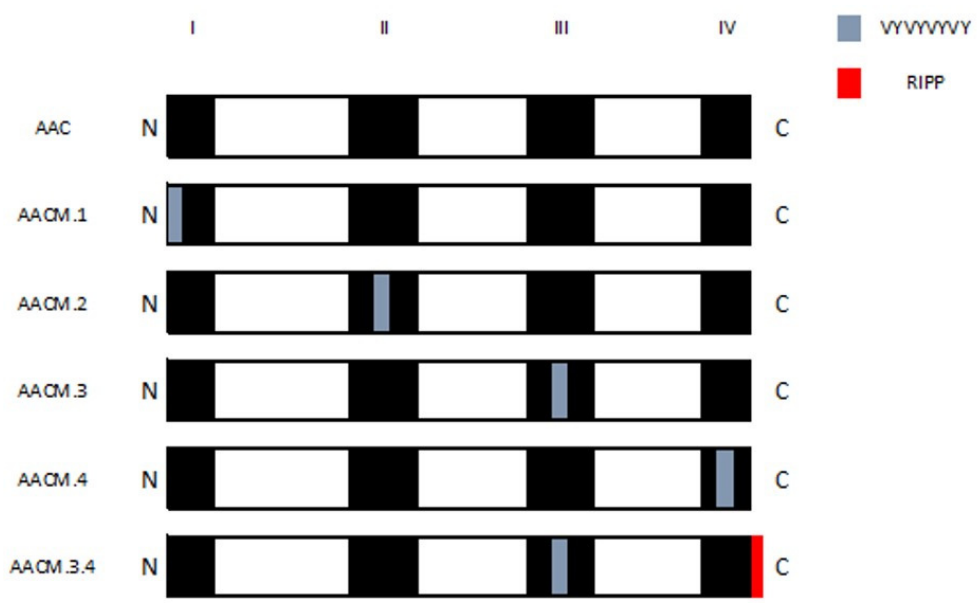
Figure 4. Schematic representation of amaranth 11S globulin acidic subunit (AAC) and their modified polypeptides with insertions of VYVYVYVY and RIPP. White and black areas represent conserved and variable regions in the primary structure, respectively. I, II, III, IV are the variable